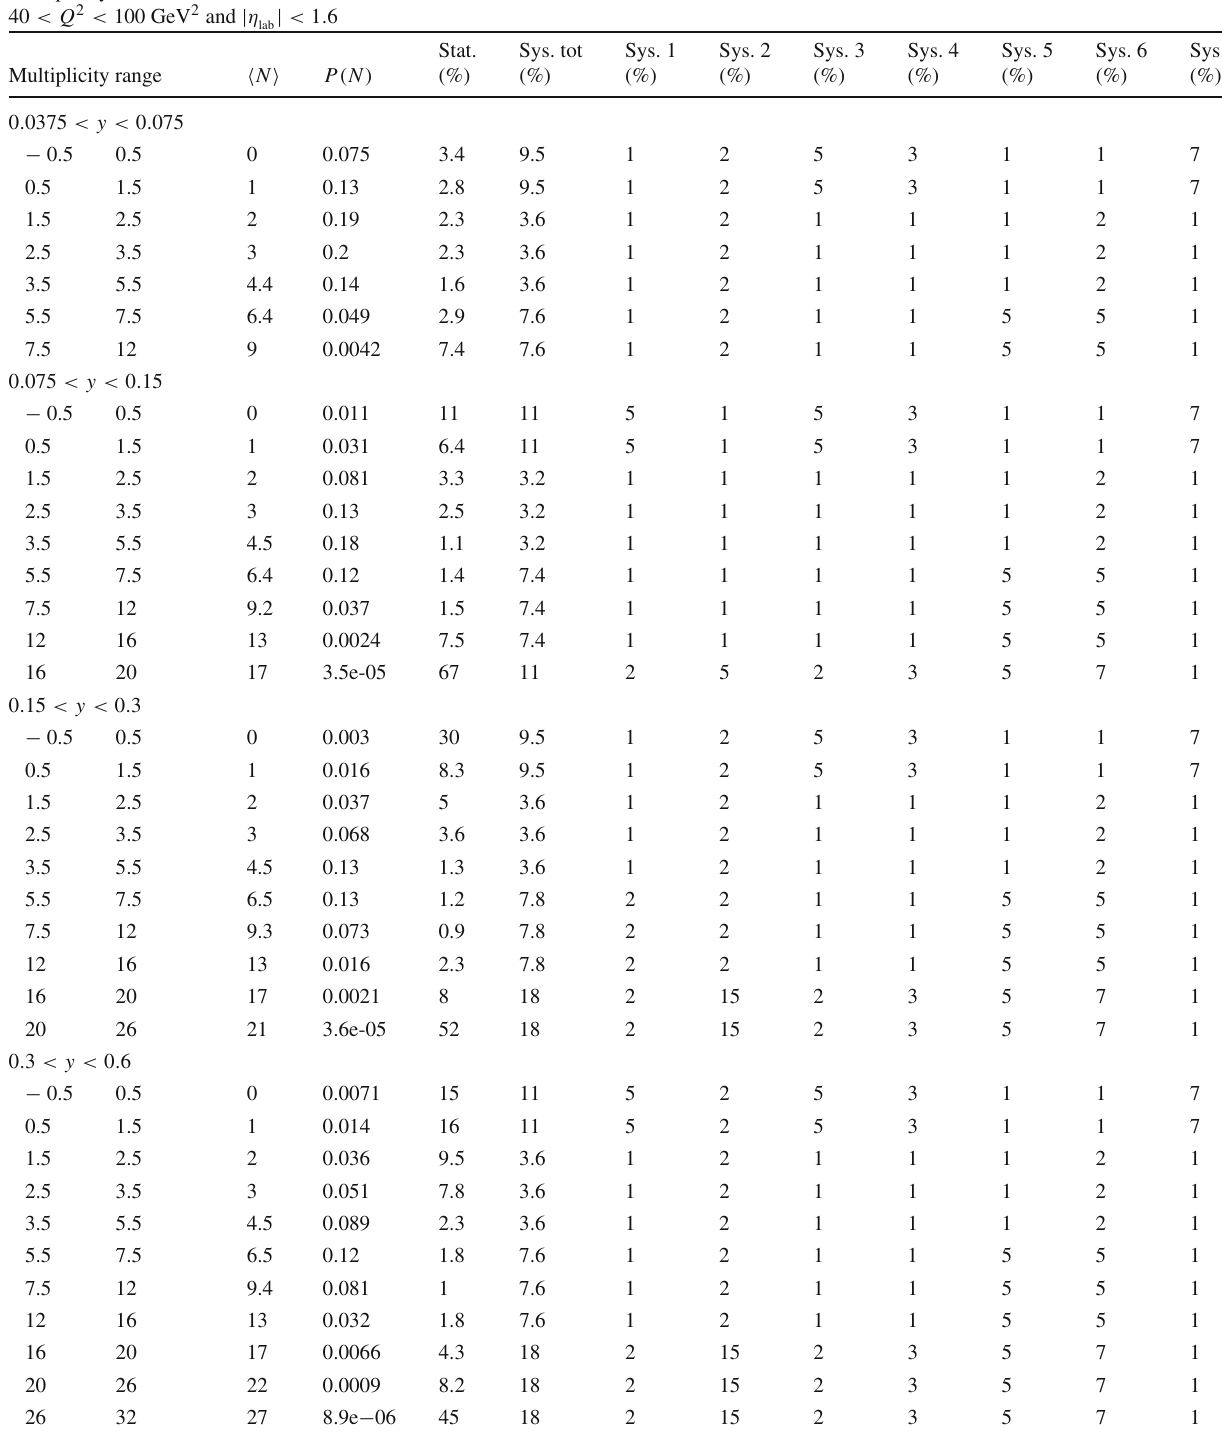
Table 12 Charged particle multiplicity distributions P ( N ) measured √ s = 319GeV with in the ranges of photon virtual- in ep DIS at ity 40 < Q 2 < 100 GeV 2 and charged particle pseudorapidity range Multiplicity distributions in DIS | < 1 . 40 < Q 2 < 100 GeV 2 and | η lab